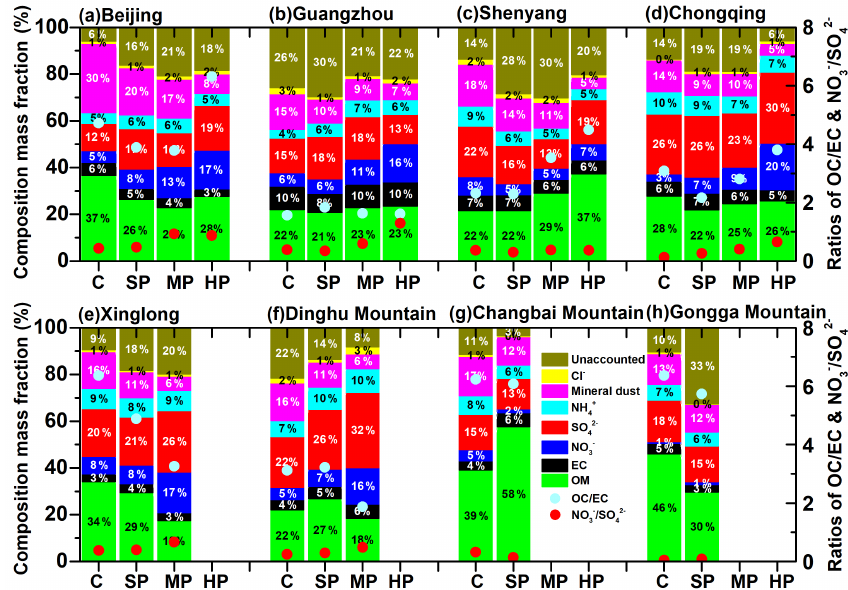
] / [ SO 2 − ] and OC / EC with respect to pollution level. The 3 4 , NO − , NH + , Mineral dust and 4 3 4